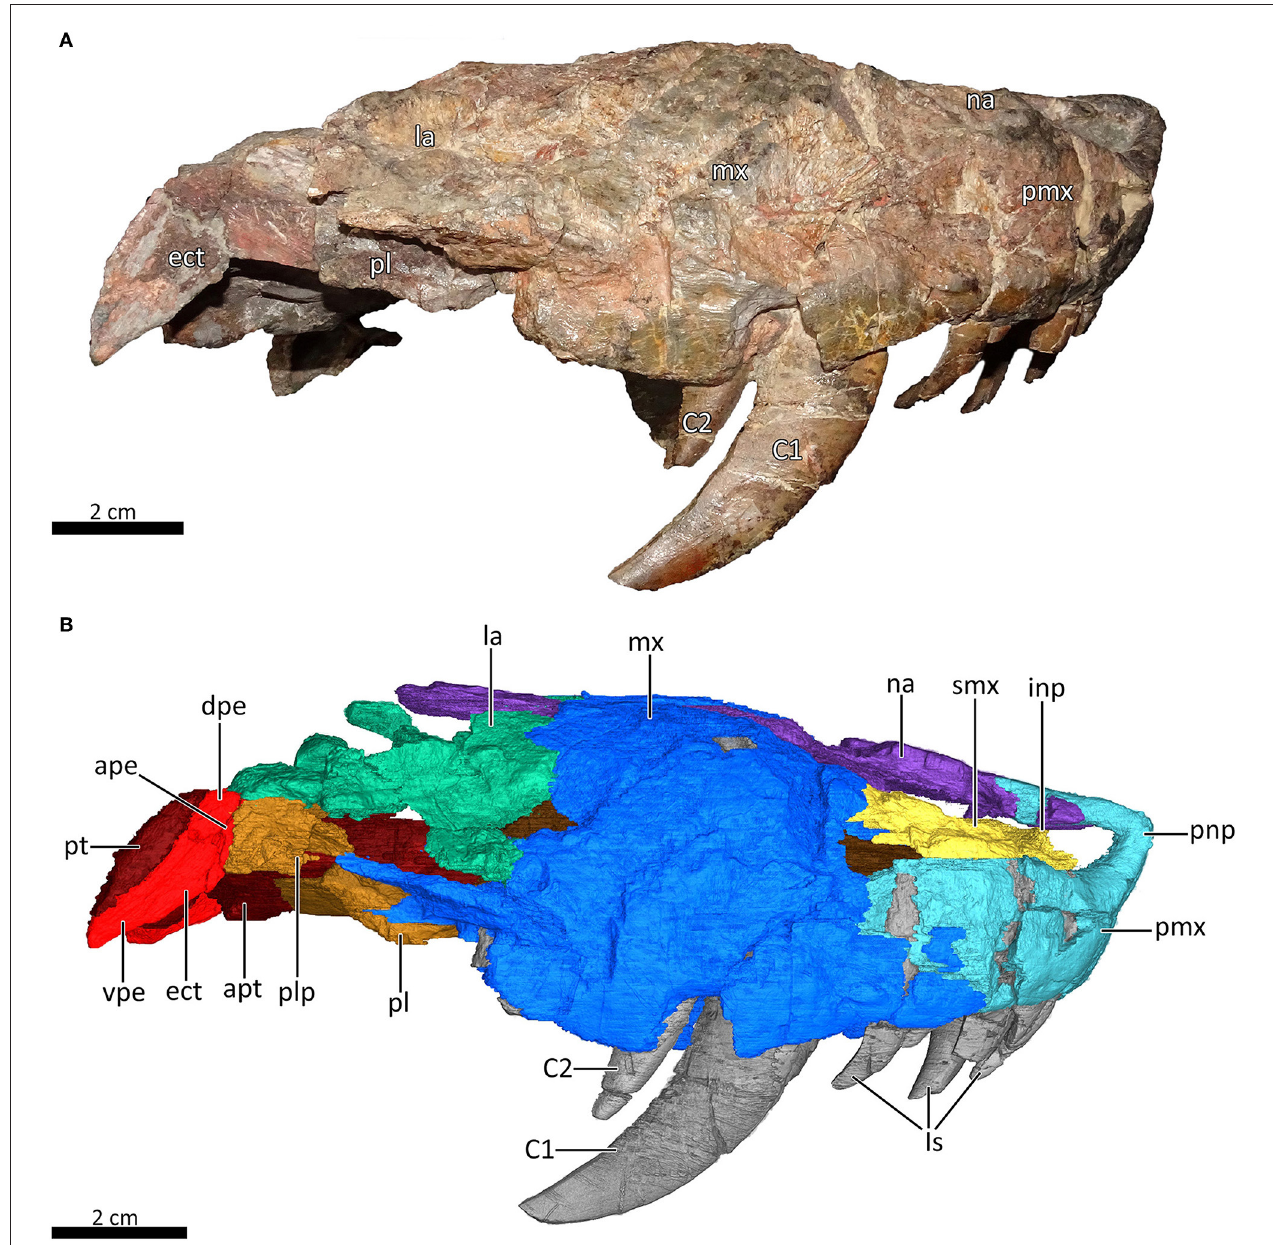
FIGURE 4 | Snout of MB.R.995 in right lateral view. (A) Photograph and (B) 3D reconstruction of the snout. ape, anterior process of the ectopterygoid; apt, anterior process of the pterygoid; C1, first canine; C2, second canine; dpe, dorsal process of the ectopterygoid; ect, ectopterygoid; inp, intranarial process; Is, upper incisors; la, lacrimal; mx, maxilla; na, nasal; pl, palatine; plp, posterolateral process of the palatine; pmx, premaxilla; pnp, prenasal process of the premaxilla; pt, pterygoid; smx, septomaxilla; vpe, ventral process of the ectopterygoid.